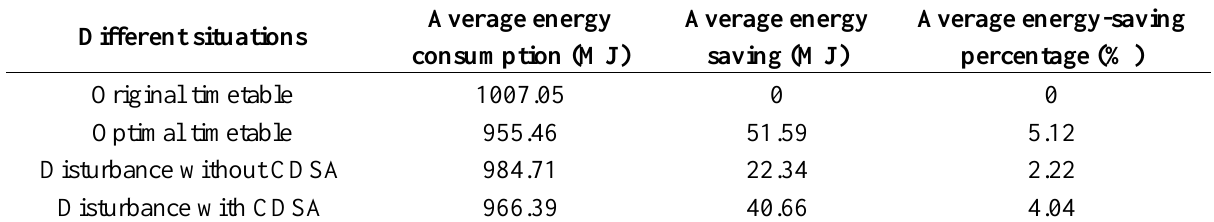
Table 5. Average energy-saving effect of different